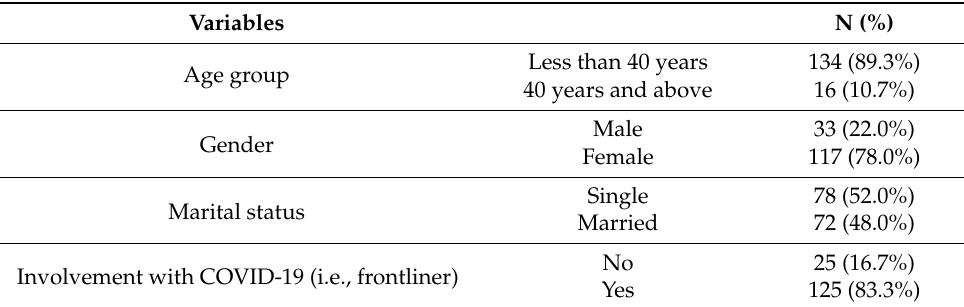
Table 1. Descriptive analysis of the healthcare workers (HCW) enrolled in the study (n =